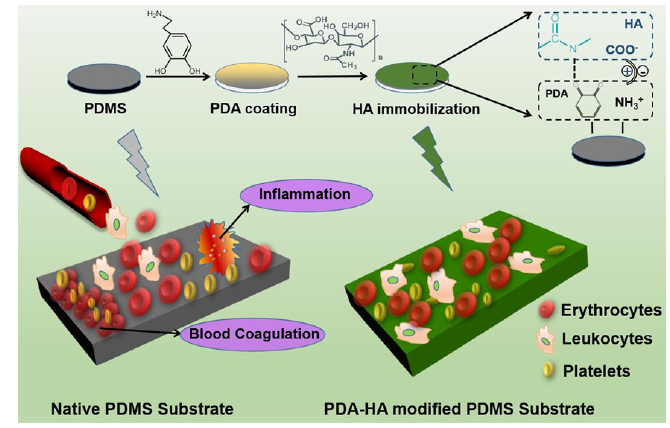
Figure 7. Schematic illustration of polydimethylsiloxane (PDMS) surface modification using hyaluronic acid and polydopamine (HA / PDA) composite coatings. (Reprinted with permission from [67]. Copyright (2017), American Chemical